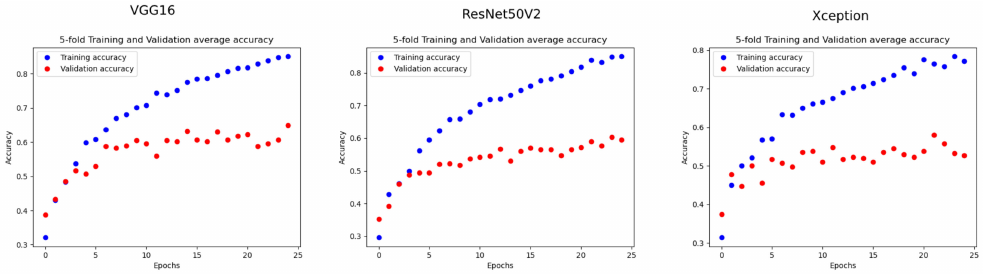
Figure 6. Five-fold cross-validation average accuracy over 40